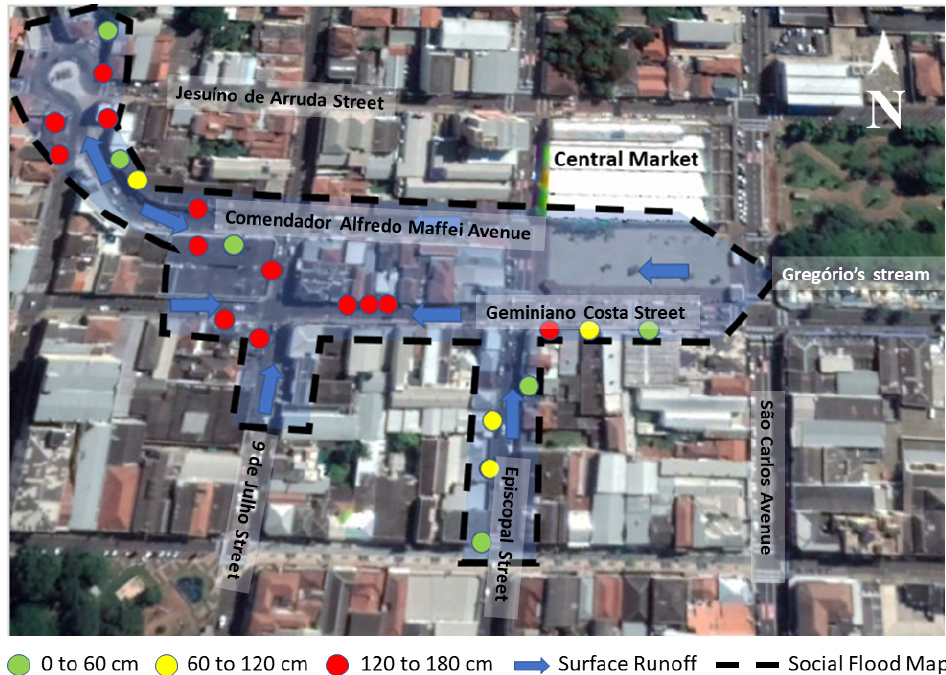
Figure 5. Social flood Map. The colors represent an external height range reached by water according to voluntary data. The dashed line represents the flooded part of the floodplain during the 12 January 2020 flood.